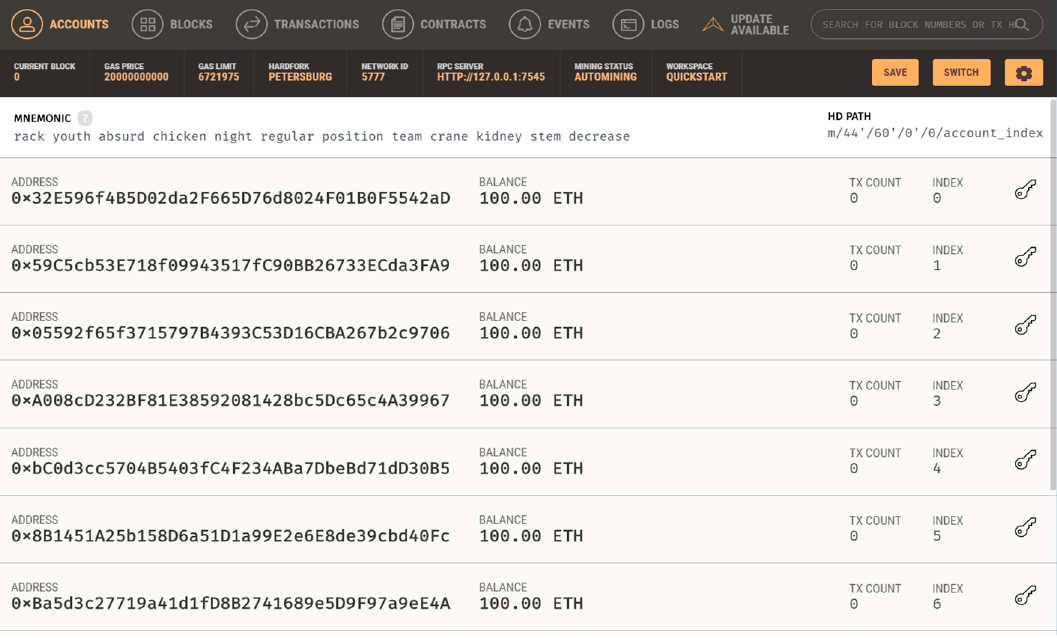
Figure 2. Ganache front page.